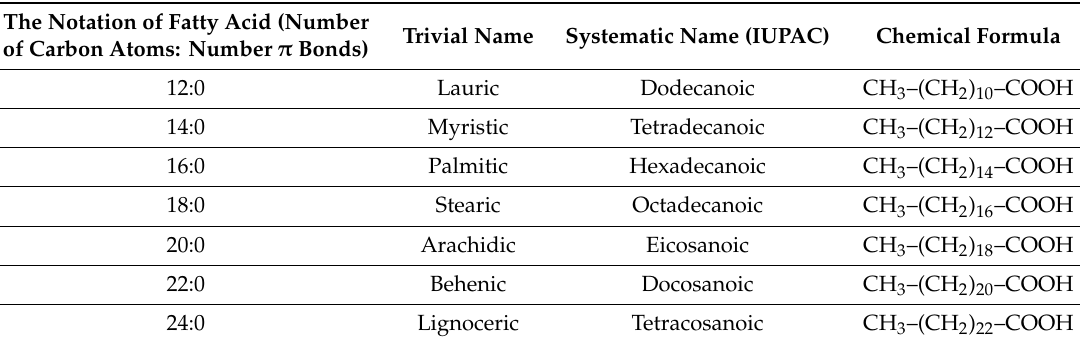
Table 1. The most physiologically important saturated fatty